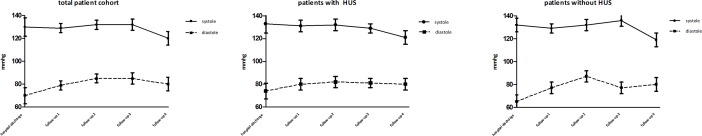
Trend of systolic and diastolic blood pressure.Patients that suffered from EHEC infection with or without HUS, at the time of their hospital discharge. FU 1 (4 month, n = 48), FU 2 (12 month, n = 34), FU 3 (24 month, n = 23) and FU 4 (42 month, n = 18) (mean ± SD).